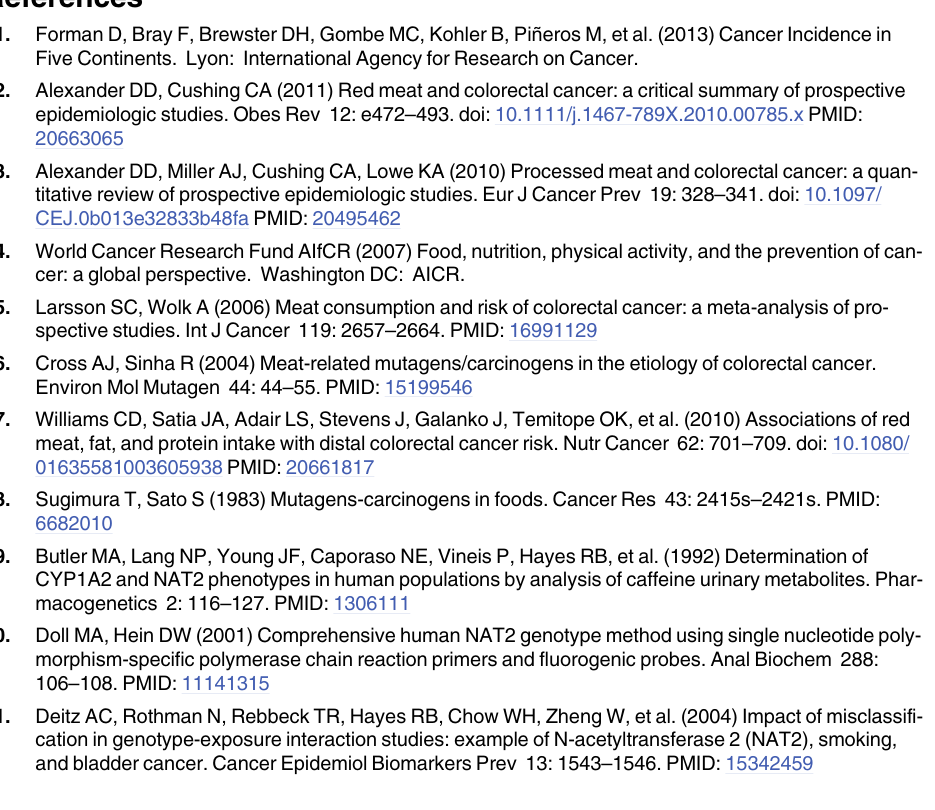
S1 Table. Associations between NAT2 and colorectal cancer in Japanese, African Ameri- cans and when the two groups were combined. S2 Table. Study-specific cut-points for 4-category red meat intake. S3 Table. Association (odds ratios and 95% confidence interval) between meat intake and colorectal cancer, with adjustment for additional risk factors. S4 Table. Association of meat intake with colorectal cancer in Japanese, stratified by NAT2 phenotype, with adjustment for additional risk factors. S5 Table. Correlation between rs1495741 genotype and inferred 7 SNP-based NAT2 phe- notype in the Japanese and African American